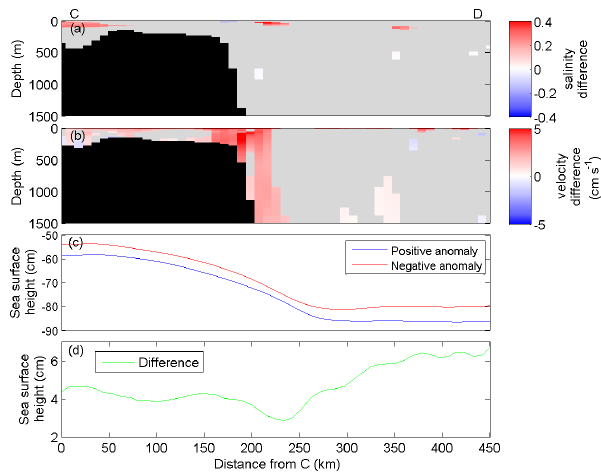
Fig. 12. Difference in salinity (a) , and velocity (b) across section CD, between times of strong positive and strong negative wind stress anomalies. Grey indicates no statistically significant difference (p < 0.01). (c) Sea-surface height across section CD during times of strong positive, and strong negative wind stress anomalies. Their difference is plotted in (d) . The offset is due to the reduced atmospheric pressure during times of strong negative wind stress anomalies. The difference is statistically significant (p < 0.01). In all panels seasonal effects have been removed, by compositing the data on the 3 strongest positive and 3 strongest negative wind stress anomalies in each calendar month for 1999 to 2004 (full description in text).